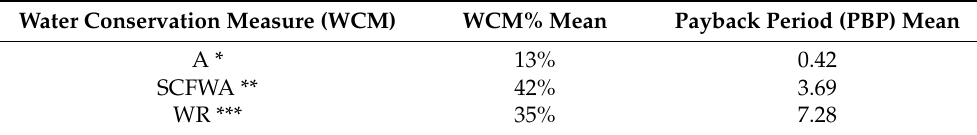
Table 10. Water conservation measures (WCMs) percentage of savings and payback period (PBP). Water Conservation Measure